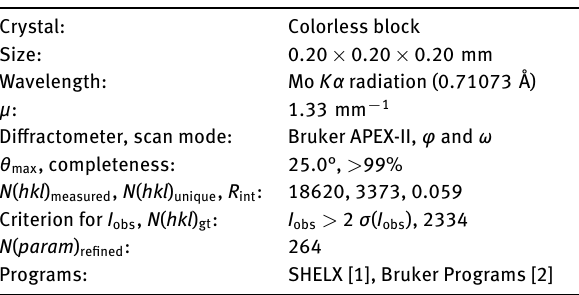
Table 1: Data collection and